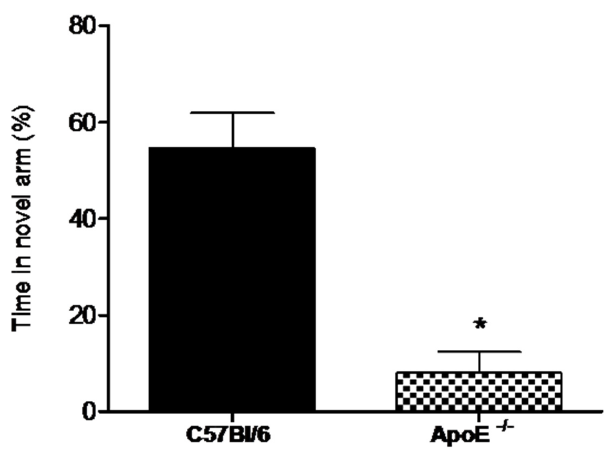
Figure 4. Female ApoE − / − mice (18 to 20 months) (n = 6) spent significantly less time in the novel arm compared to age-matches C57Bl/6 mice (n = 8). Values are expressed as means ± SEM. * Significant difference Vs C57BL/6 mice (T(7) = 5.60, p = 0.0018). Mann Whitney U Test.